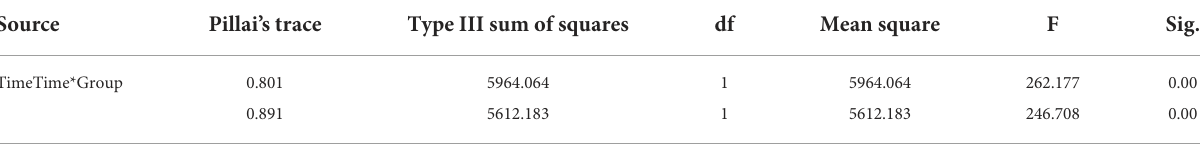
TABLE 3 Tests of within-subjects effects for EI scores.